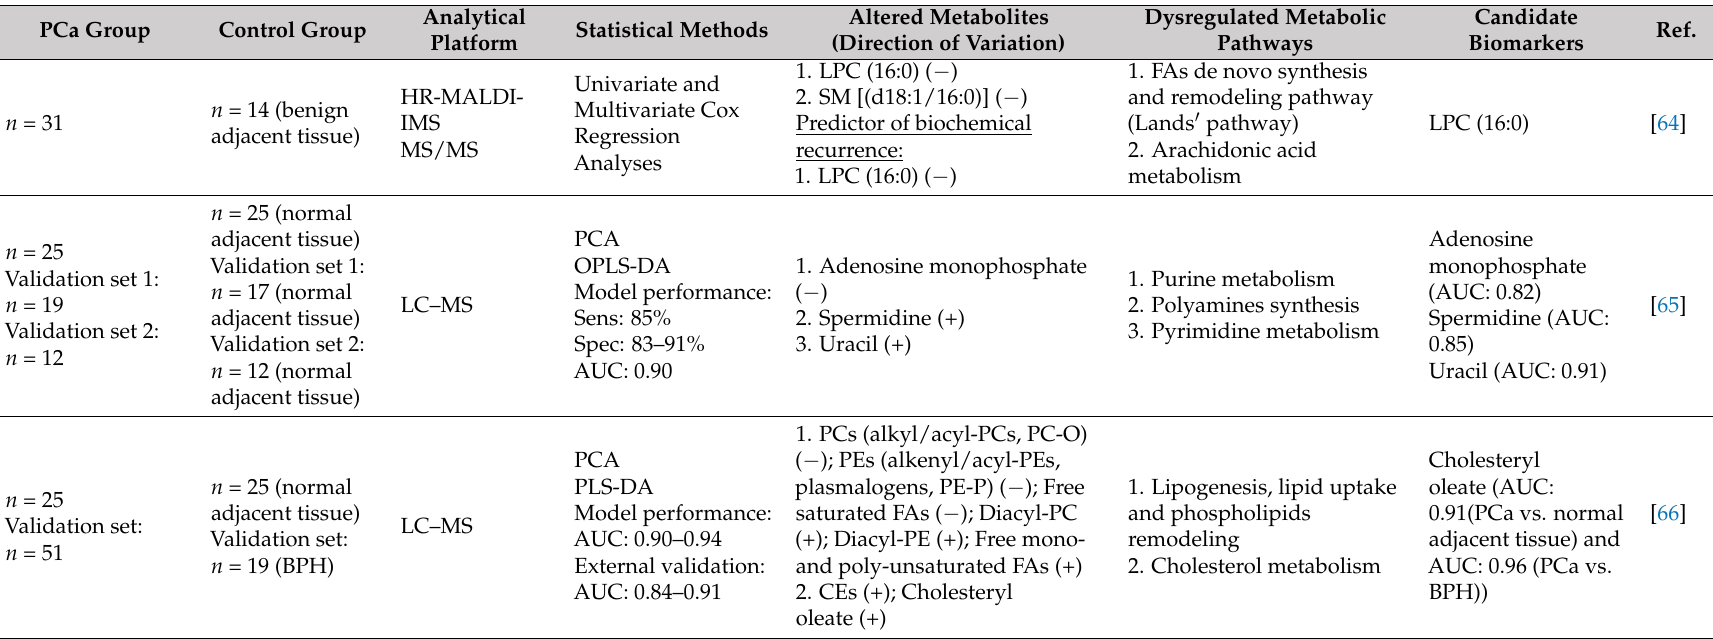
Table 2. Metabolomic studies performed in tissue samples from PCa patients in the last 5 years